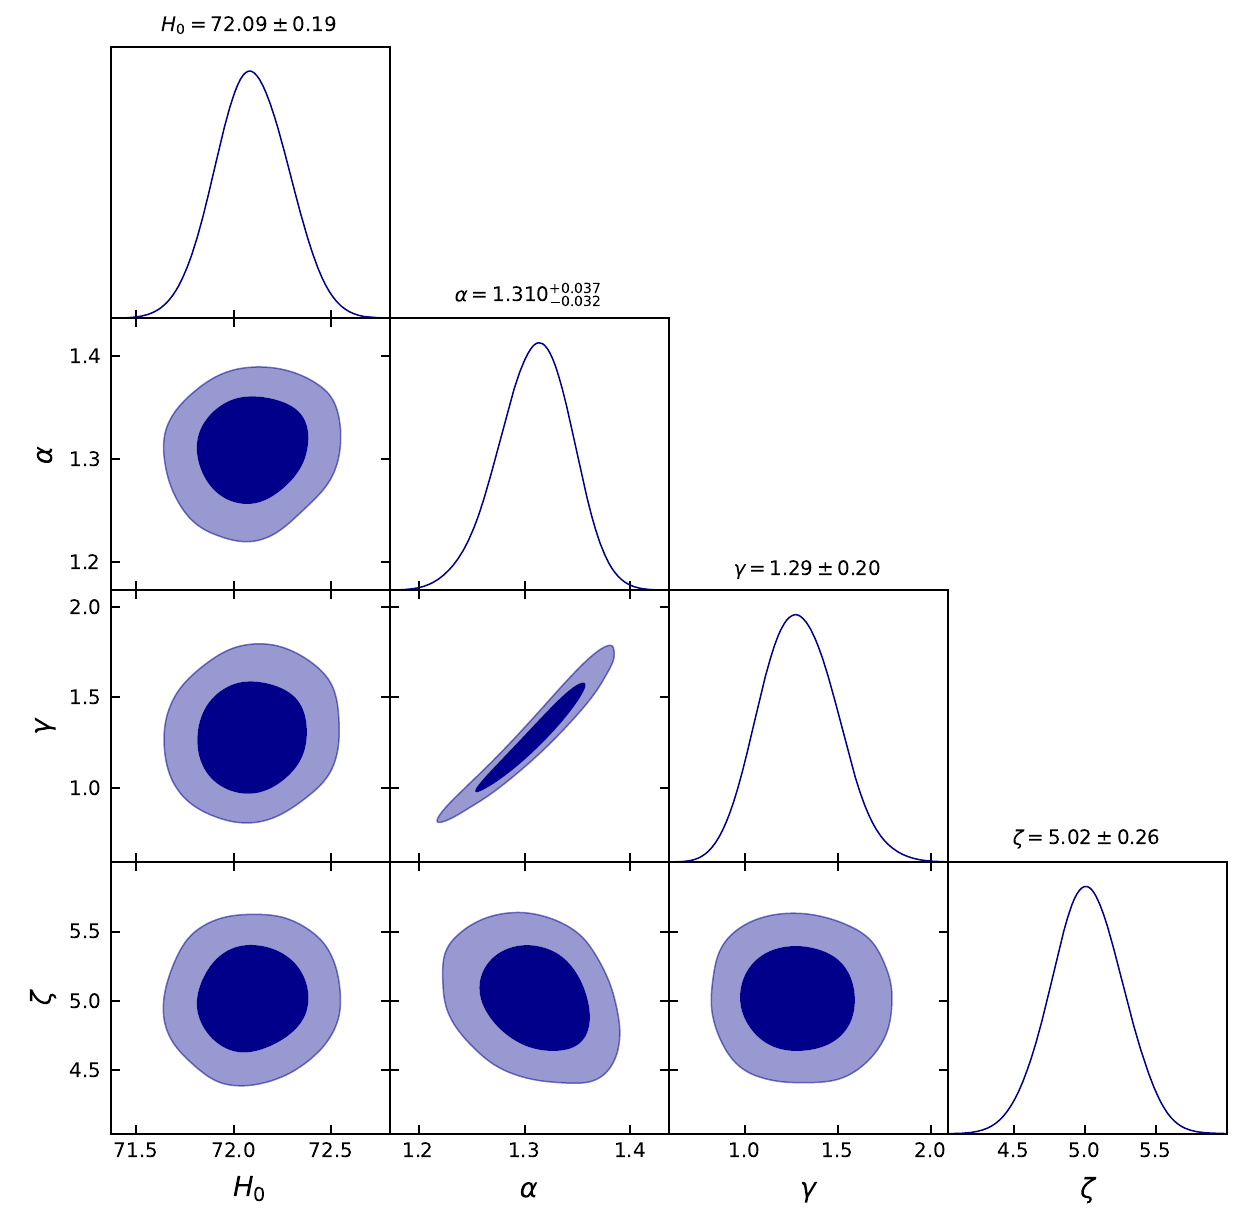
Figure 1. The 1 σ and 2 σ contours for the model parameters α , γ , ζ , and H 0 , using the combined H ( z ) + Pantheon + Analysis